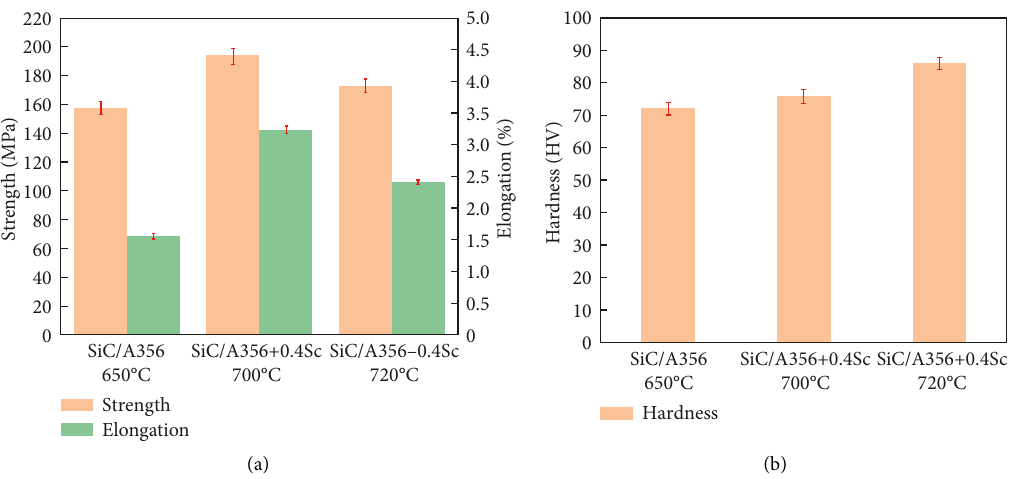
Figure 10: Mechanical properties of the SiC p /A356 composites at different conditions: (a) tensile properties; (b) microhardness.